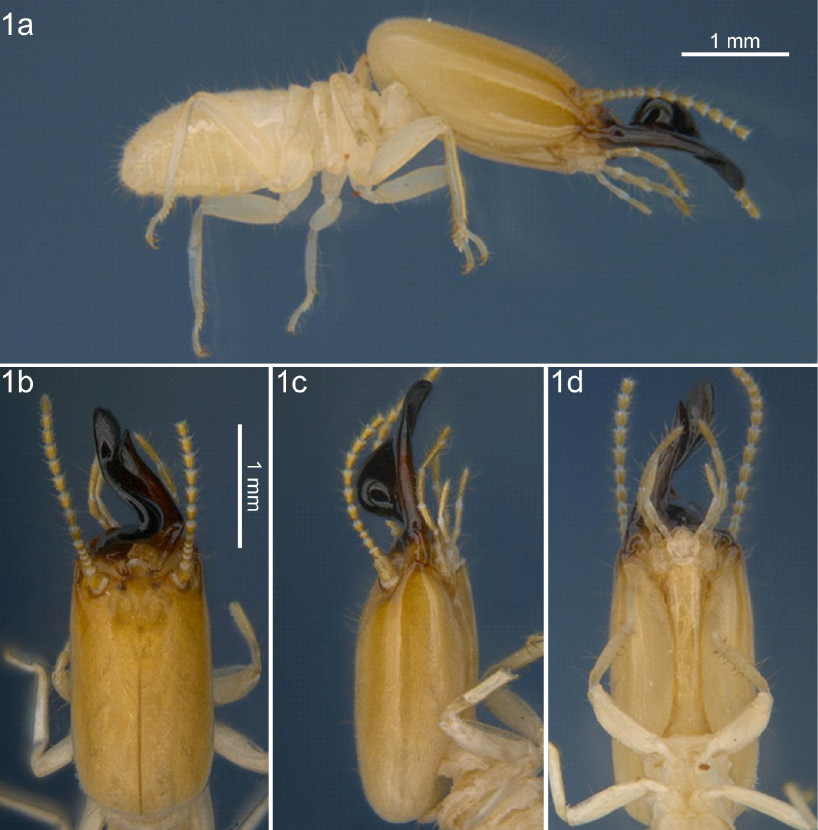
Fig 1 . Pericapritermes ceylonicus (Holmgren) soldier (KSNUAHS); a) Lateral view of body; b) Dorsal view of head; c) Lateral view of head; d) Ventral view of head.